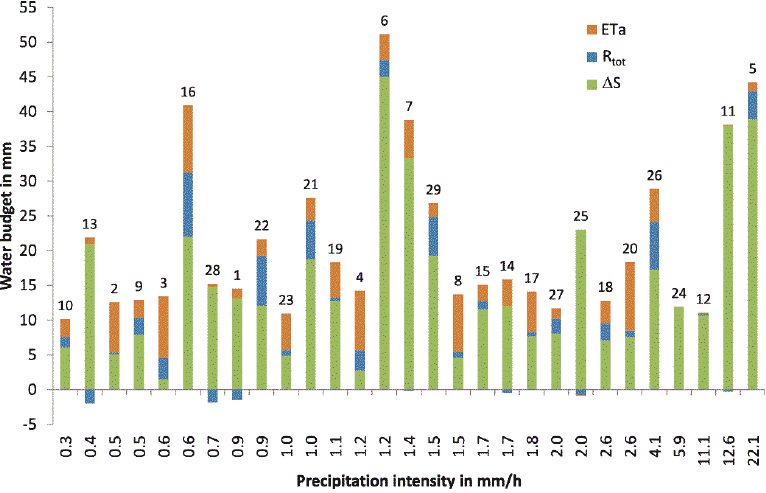
Figure 5. Water budget (ETa—actual evapotranspiration, R tot —runoff, ∆ S—water storage change) for all selected rainfall events between start of precipitation and end of drainage (event ID above bar). Table 1. Average partitioning of P into water budget components ∆ S, R tot and ETa for the period ∆ t tot . Hydraulic Conditions at t startP